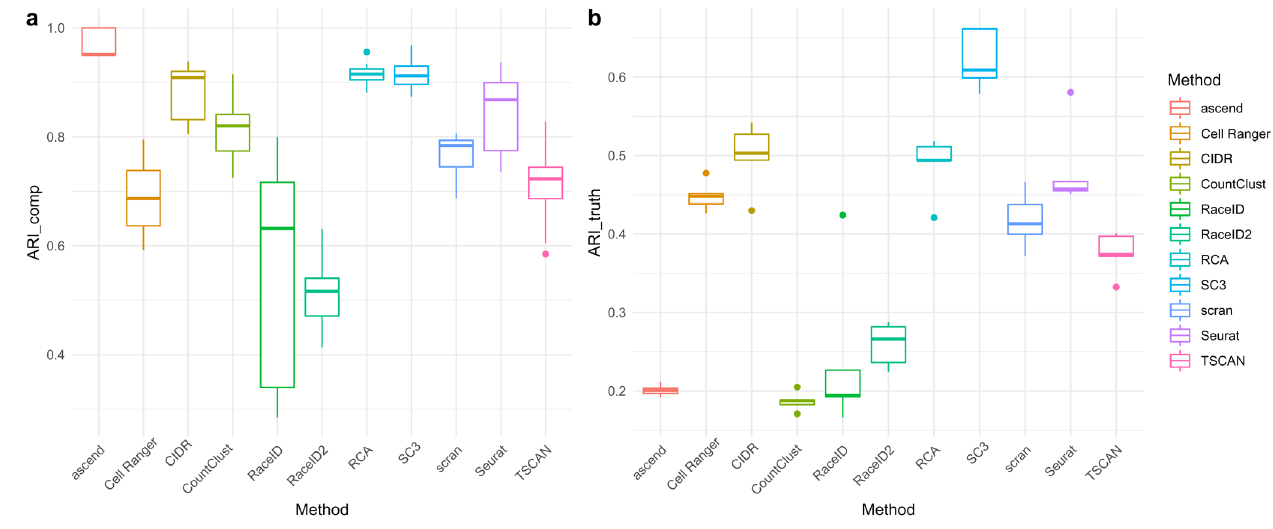
Figure 5. ( a ) Tukey boxplots of ARI_comp results from the comparison of clustering solutions of the same method when cell input was varied in Dataset 5. ( b ) Tukey boxplots of ARI_truth of clustering solutions of the same method when cell input was varied in Dataset 5. Results shown are for evaluation 2 (R version 3.5.0) for results of evaluation 1 (R version 3.4.3) see Supplementary Figure